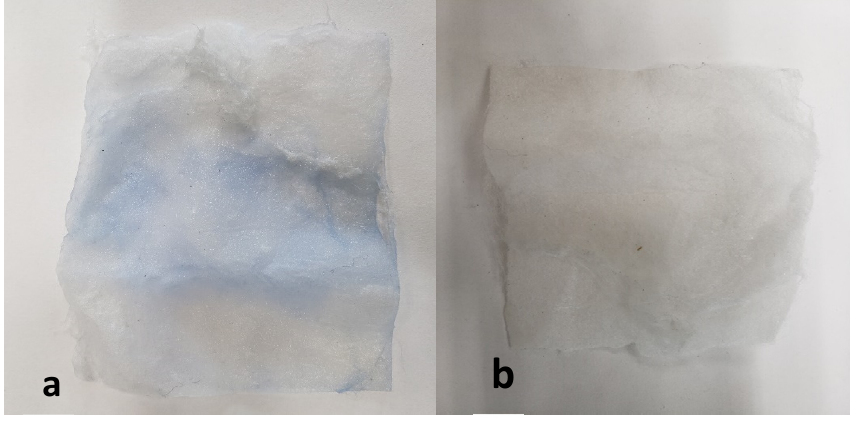
Figure 11. ( a ) Non-woven fabric with MB; and ( b ) non-woven fabric after one hour irradiation with UV lamp.